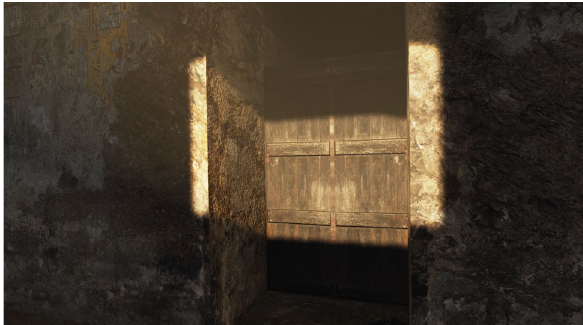
Figure 13 . View from the transverse room towards the longitudinal room. Step 1 with the entrance door closed.